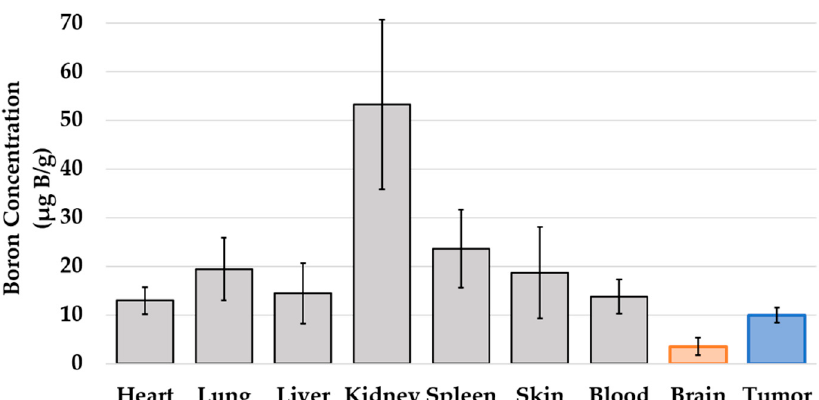
Figure 4. Boron concentrations in various organs of mouse CNS lymphoma models treated with BPA. Tumors had significantly higher boron concentrations (9.9 ± 1.6 μ g/g) compared to the brain (3.5 ± 1.8 μ g/g: p < 0.05). The tumor to brain ratio (: T/Br) was 2.85. The tumor to blood ratio (: T/Bl) was 0.72. Boron accumulation was also observed in other organs.